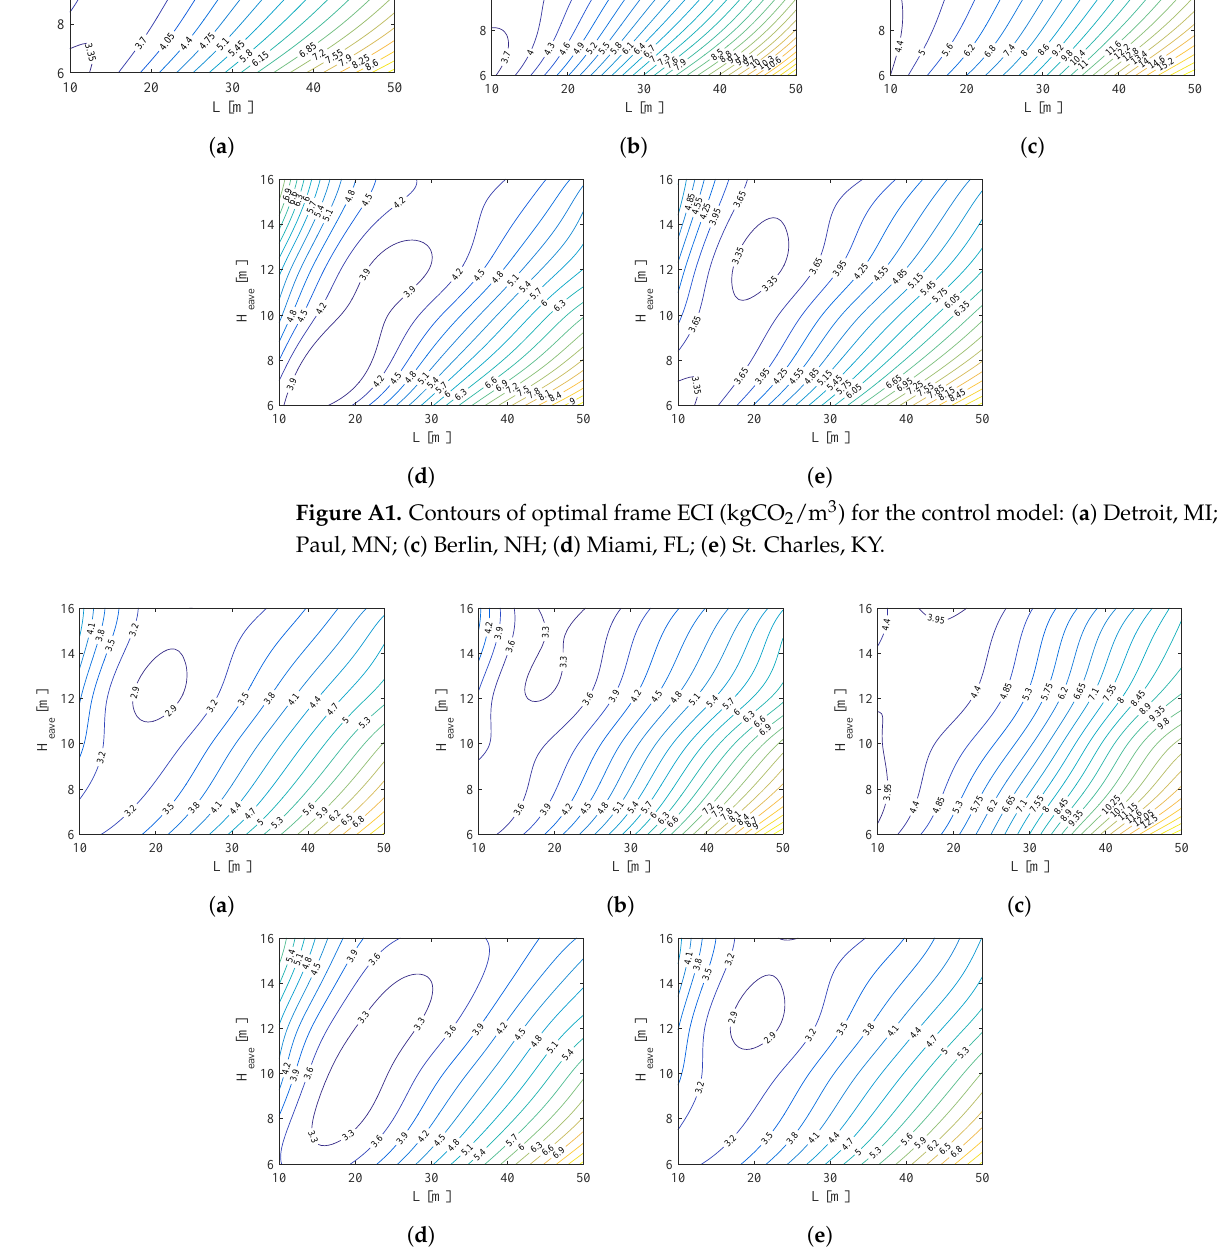
Figure A2. Contours of optimal frame ECI (kgCO 2 /m 3 ) for Model 1: ( a ) Detroit, MI; ( b ) St. Paul, MN; ( c ) Berlin, NH; ( d ) Miami, FL; ( e ) St. Charles,